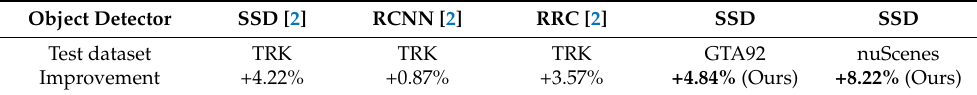
Table 3. Comparison of improvements to object detection on divergent distributional